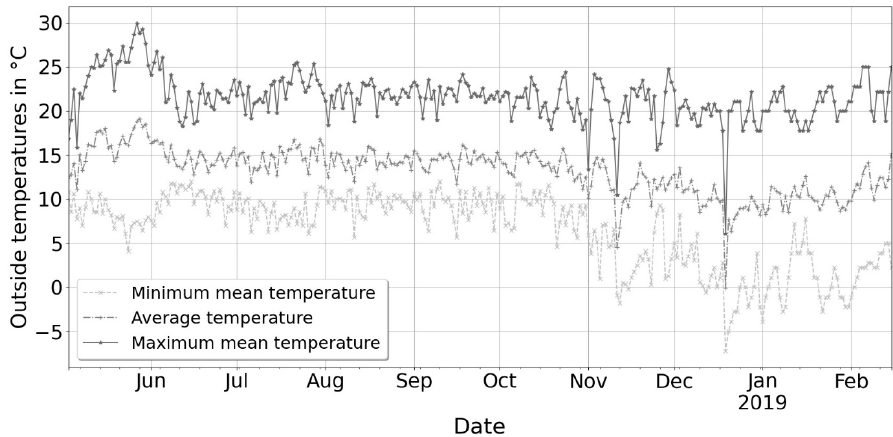
Figure 3. Daily outdoor temperatures in Toluca from May 2018 to February 2019. Light grey represents the minimum, mid-grey the average, and dark grey the maximum.